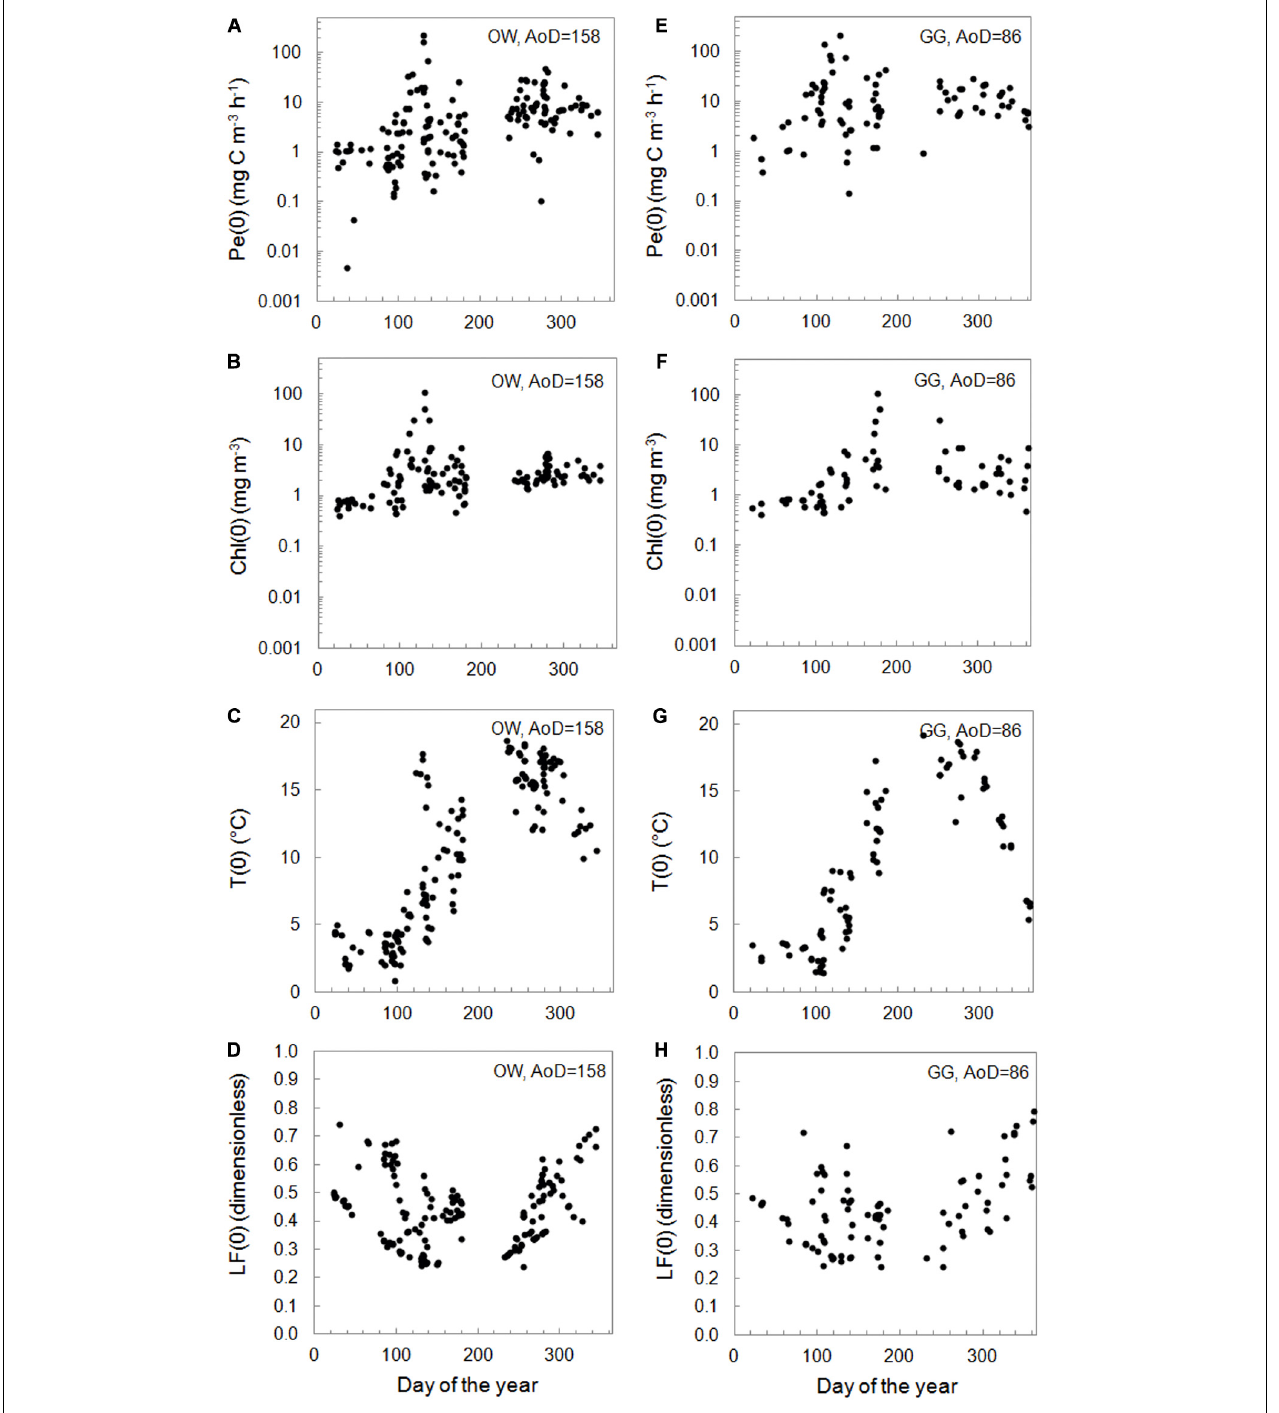
FIGURE 4 | The surface PP, Pe(0) (A,E) , chlorophyll a concentration – Chl(0) (B,F) , temperature − T(0) (C,G), and light factor − LF(0) (D,H) versus number of the day in year within 1993–2018 in the Baltic Proper (OW, left column ) and the Gulf of Gdansk (GG, right column ).